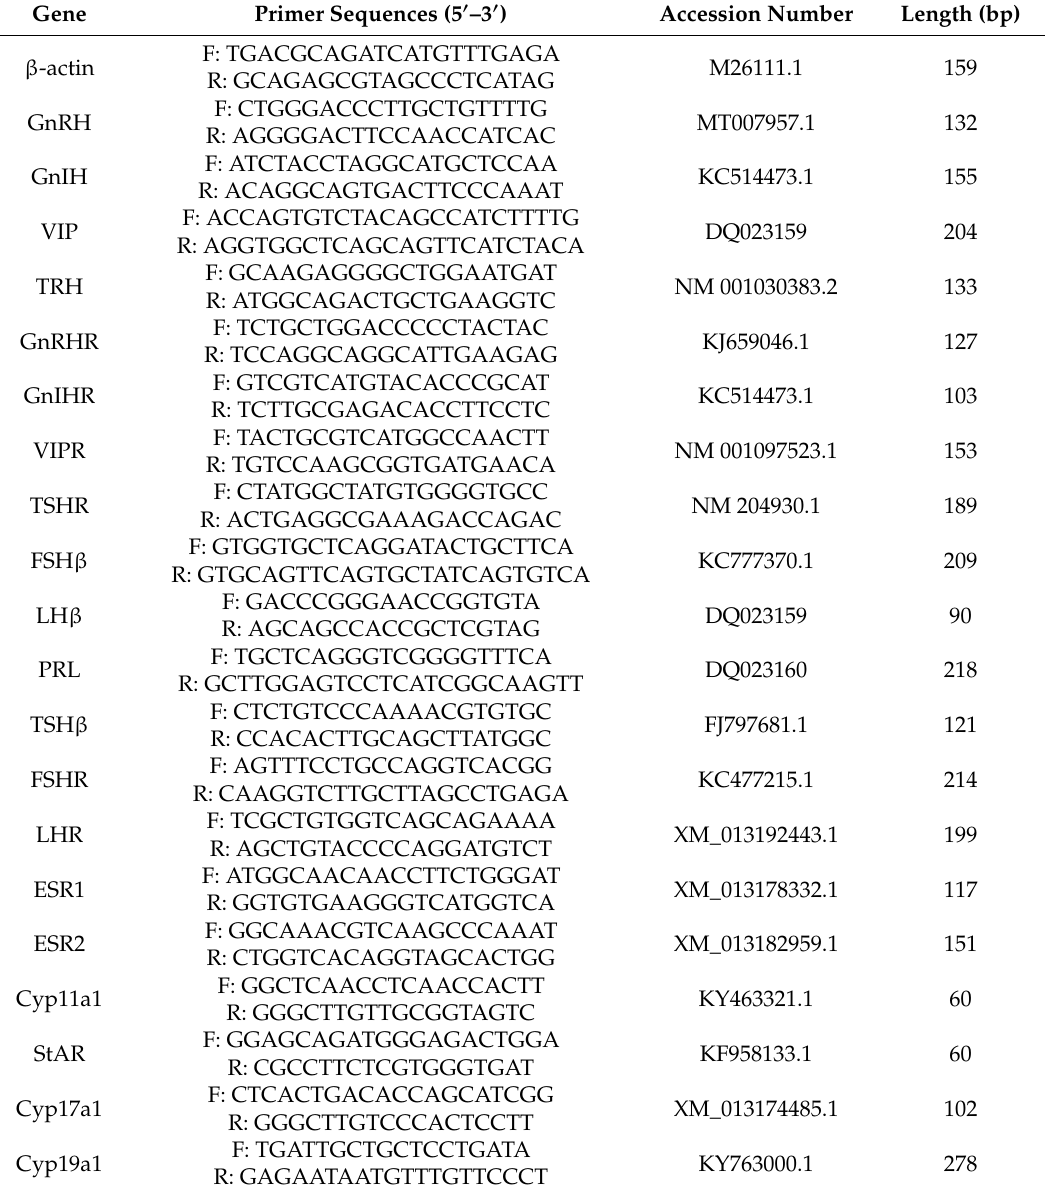
Table 1. Primers used in the real-time quantitative PCR of genes in goose